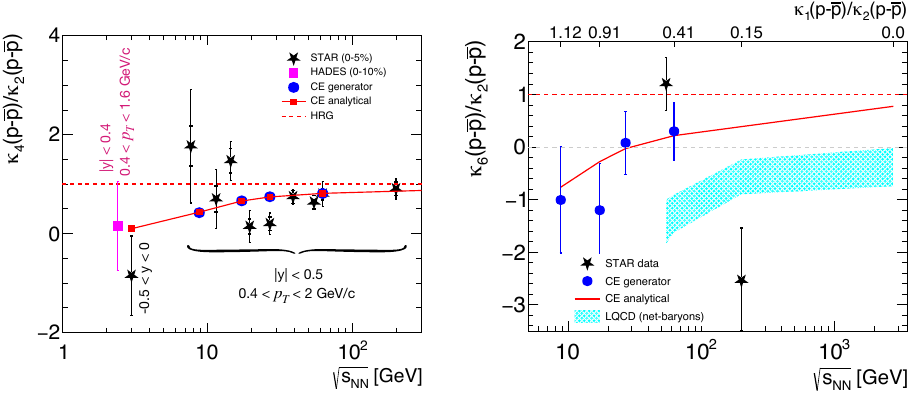
Figure 1. Left panel: evolution with the collision energy of κ 4 /κ 2 measured for net-proton distributions. The STAR data, represented with black star symbols, are measured for | y |< 0.5 (-0.5 < y < 0 for the lowest energy) and 0.4 < p T [GeV / c] < 2. The HADES measurement (magenta square symbol) is for | y | < 0.4 and 0.4 < p T [GeV / c] < 1.6. Also presented are two non-critical baselines; the HRG baseline: indicated with the dashed line at unity, the CE baseline: shown by solid the red line / boxes (analytical calculations) and blue symbols (generated values). Right panel: Similar to the left panel for κ 6 /κ 2 . The corresponding lQCD results for net-baryons are presented with the hashed cyan